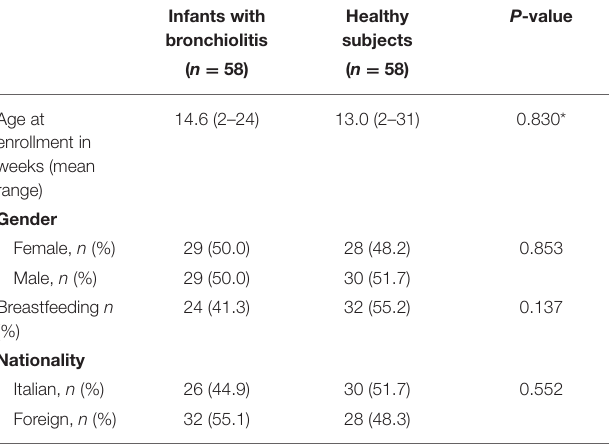
TABLE 1 | Epidemiological characteristics of enrolled